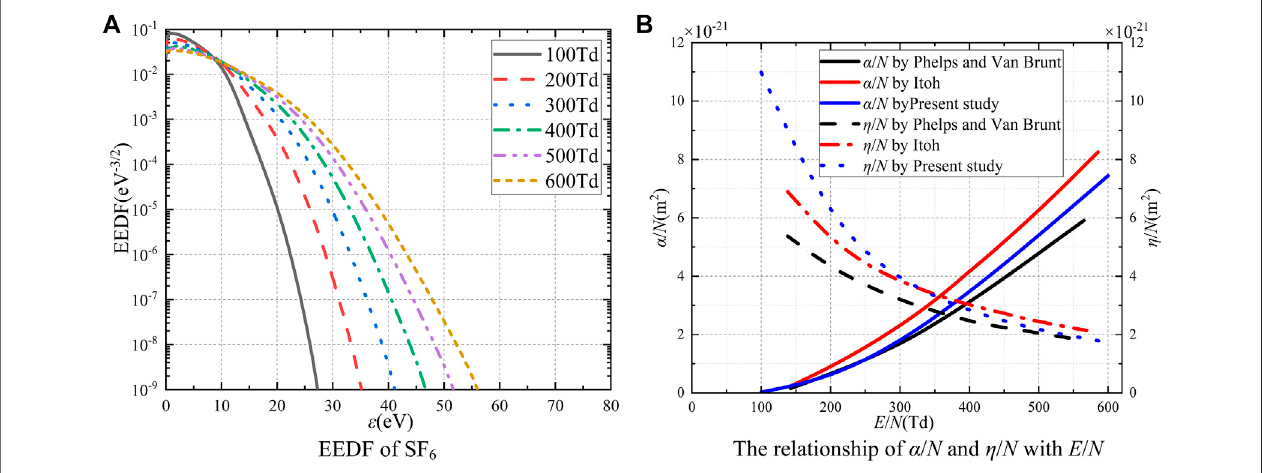
FIGURE 1 | (A) EEDF of SF 6 ; (B) the relationship of α / N and η / N with E / N